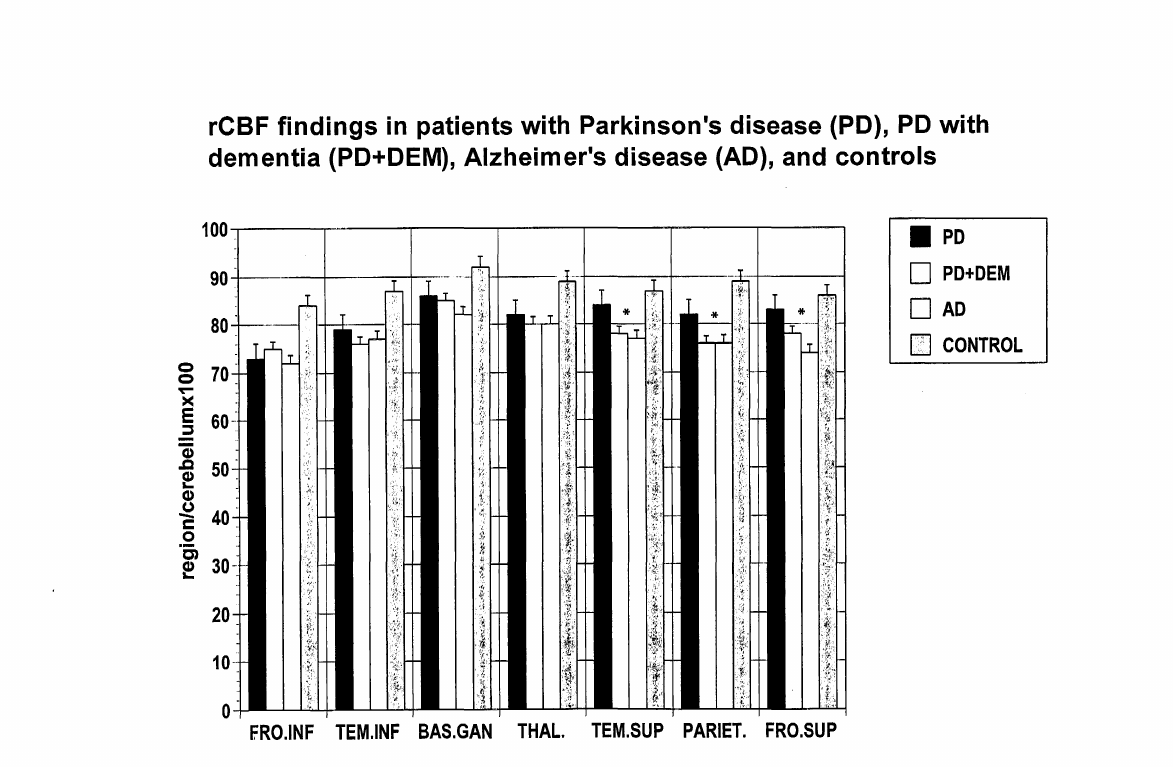
FIG.1. Patients with AD had significantly lower perfusion in temporal superior (TEM.SUP), parietal (PARIET.) and frontal superior areas (FRO. SUP) than non-demented patients with PO (*p < 0.01, P < 0.05, and p < 0.0001, respectively) and controls (*p < 0.01, P < 0.0001, and p < 0.0001, respectively). Patients with PO and dementia had significantly lower perfusion in temporal superior, parietal, and frontal superior than non-demented patients with PO (all p < 0.01), and controls (*p < 0.01, P < 0.001 and p < 0.0001, respectively). All three patients groups had significantly lower bilateral perfusion in inferior frontal and temporal regions as compared to the control group (p <